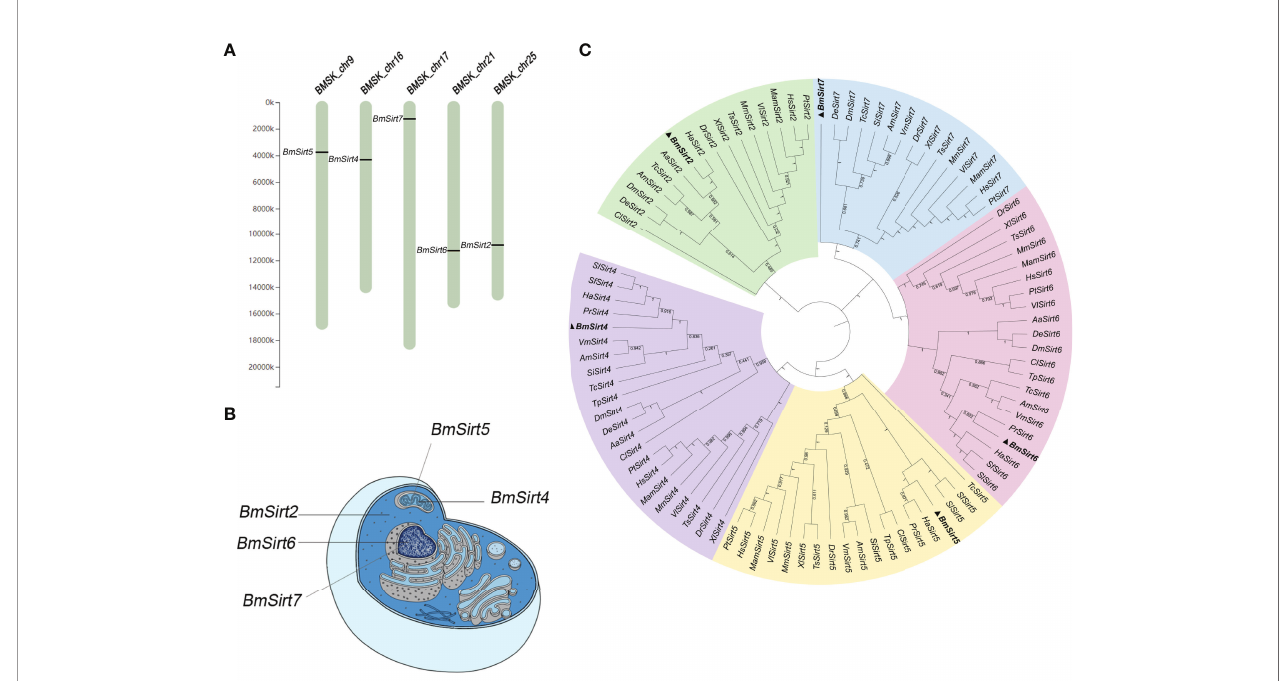
FIGURE 1 | Chromosomal location, subcellular localization and phylogenetic analysis of silkworm members of the Sirtuin Family. (A) Chromosomal location of the silkworm Sirtuin genes. (B) Predicted subcellular localization of silkworm Sirtuin genes. (C) Phylogenetic analysis of Sirtuin family members from the silkworm and other insect, invertebrate and vertebrate species. Bayesian phylogenetic tree was generated based on the Sirtuins nucleotide sequences (The Gene ID of each sequence is shown in Table S2 ). Five branches were color-coded with cyan (Sirt2), purple (Sirt4), yellow (Sirt5), pink (Sirt6) and green (Sirt7). Aa, A ; albopictus Hs, H ; sapiens; Mm, M ; musculus; Dr, D ; rerio; Bm, B ; mori; Dm, D ; melanogaster; Am, A ; mellifera; Tc, T ; castaneum; Xl, X ; laevis , Pt, P ; troglodytes , Mam, M ; mulatta , Ts, T ; scripta elegans , Vl, V ; lagopus , Cl, C ; lectularius , Sf, S ; frugiperda , Ha, H ; armigera , De, D ; elegans , Si, S ; invicta , Vm, V ; mandarinia , Pr, P ; rapae , Tp, T ; palmi , Sl, S ; litura